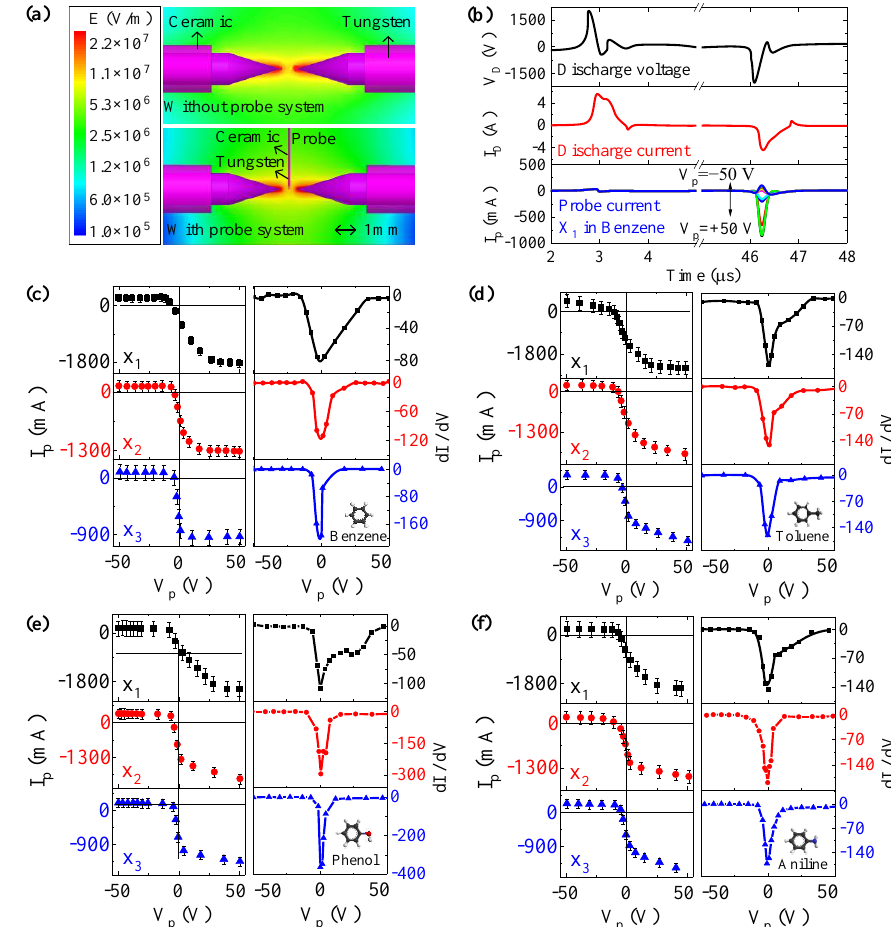
Figure 2. ( a ) The schematic diagram of the distribution of electric field with or without the Langmuir probe system. ( b ) Typical discharge voltage, discharge current, Langmuir probe voltage, and current response characteristics (DC bias voltage from − 50 V – 50 V) at position X 3 in benzene solution discharge under the excitation of 1.6 kV. ( c – f ) The response characteristics IV curve and the first differential of the Langmuir probes of the negative SPP at different locations of X 1 (plasma phase), X 2 (plasma–gas phase), and X 3 (gas–liquid phase) in benzene, toluene, phenol, and